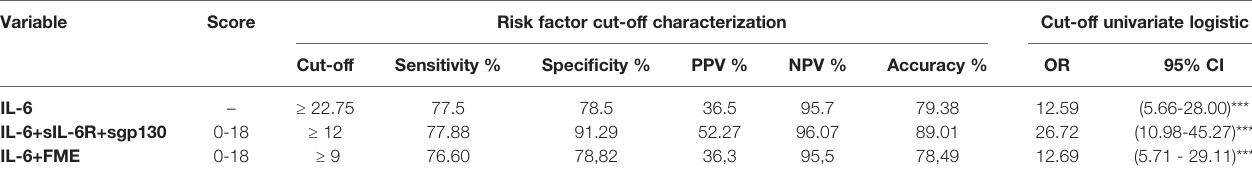
NPV, Negative predictive value; PPV, Positive predictive value; B/T, Binary/ternary complex ratio; FME, Fold molar excess of sgp130 over sIL-6R; OR, Odds ratio. ***p <